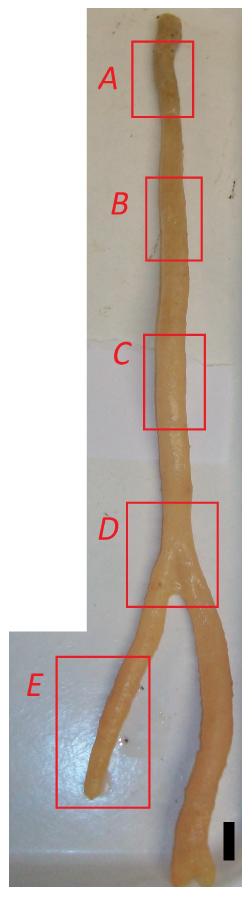
Figure 1. Specimen DH19-2, Asbestopluma sp. Scale bar shows 1cm. Red boxes show subsampling sections